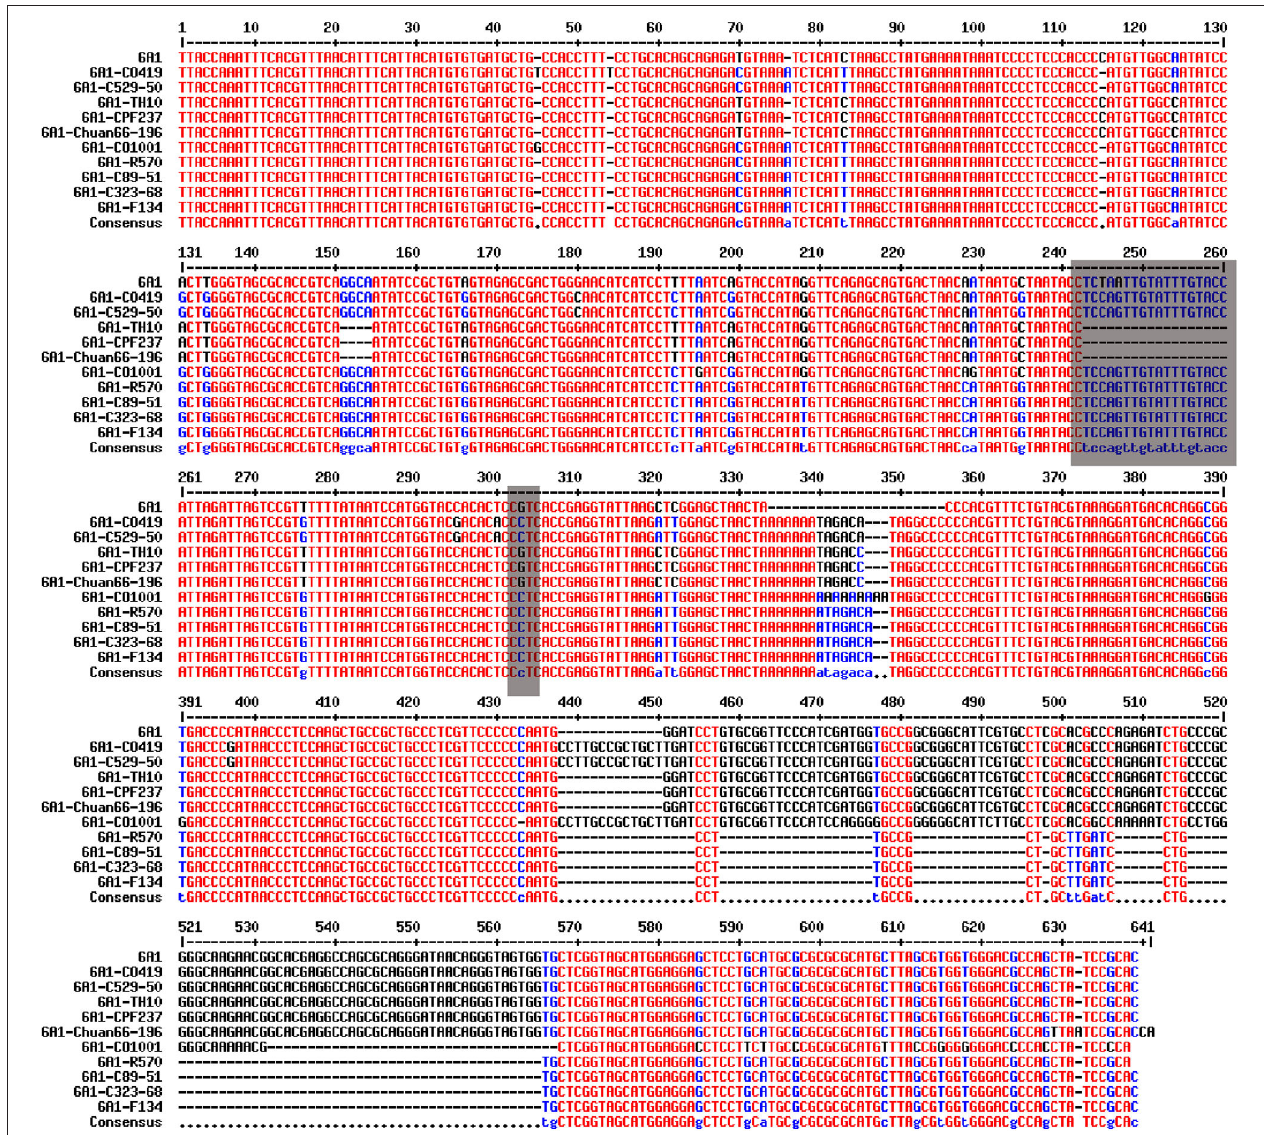
FIGURE 1 | Blast results of amplification sequences of SNP SS6A_102766953-G-C from 10 sugarcane core parents and their derived lines.